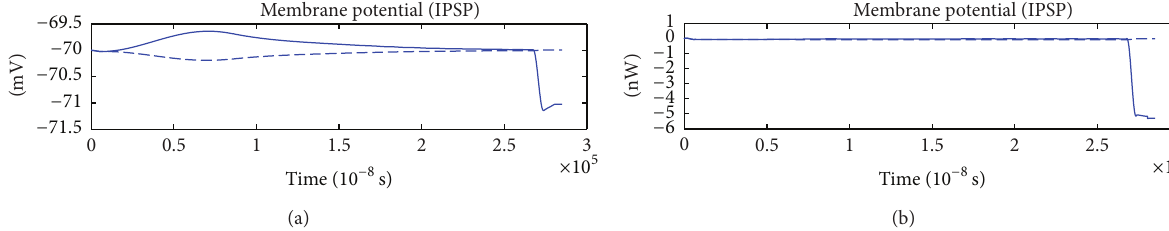
Figure 21: The IPSP and the corresponding energy function. 𝑟 0𝑚 = 0.0001 Ω , 𝑟 1𝑚 = 0.1 Ω , 𝑟 2𝑚 = 1000 Ω , 𝑟 3𝑚 = 0.1 Ω , 𝑟 𝑚 = 1000 Ω , 𝐶 𝑚 = 1 𝜇 F, = 50 𝜇 H, 𝑖 = −0.7 𝜇 A, and 𝑄 = 1 × 10 −6 𝜇 A. 𝐿 𝑚 0𝑚